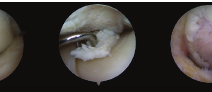
Figure 2: Intraoperative arthroscopic images in display of large separated fragment in situ, unstable under probing with remaining large cartilage lesion at dorsomedial femoral condyle after removal.